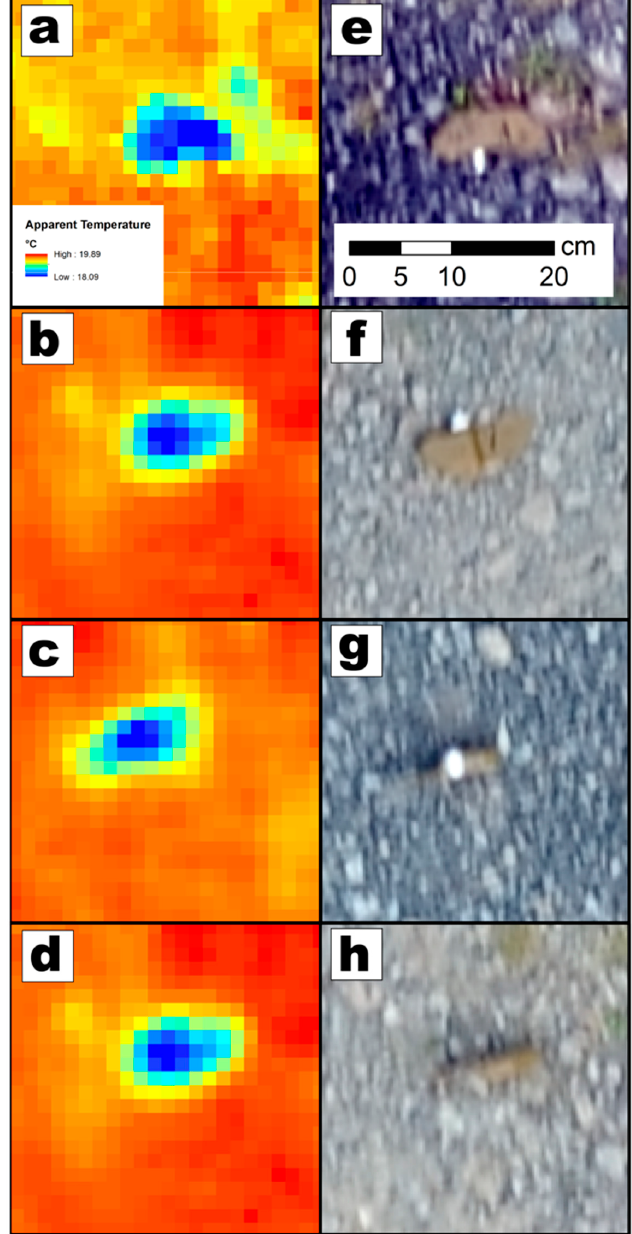
Figure 5. Apparent temperature of PFM-1 mines in ( a ) opposite flat, ( b ) flat, ( c ) cap up, and ( d ) cap down orientations at 6:45 A.M. Aerial photogrammetry model from mid-day flight of mines in ( e ) opposite flat, ( f ) flat, ( g ) cap up, and ( h ) cap down orientations.